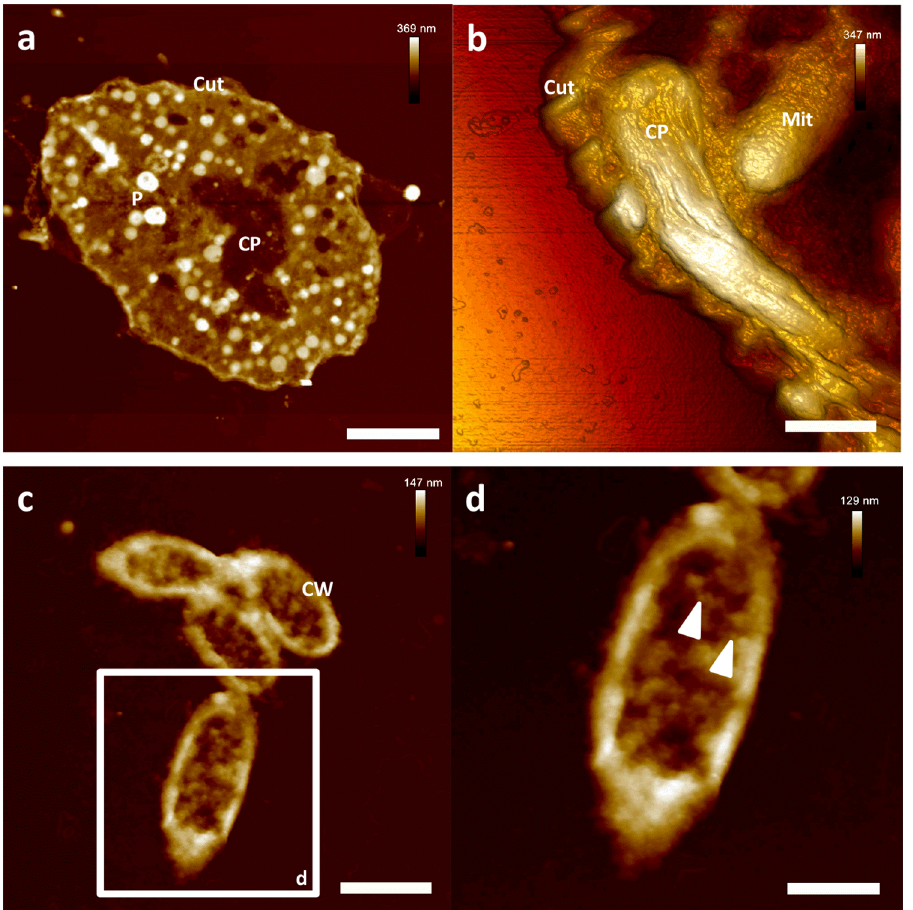
Figure 6. AFM-based ultrastructural imaging of eu- and prokaryotic cells of representative cell culture experiments. Nanoscopic resolution of the internal morphology of single cells. ( a ) Cross section of a single Euglena gracilis cell. ( b ) High resolution detail of an ultra-section from E. gracilis (3D representation). ( c ) Ultra- section of a group of E. coli bacteria. ( d ) Close up on a single E. coli individual. Note the depiction of single particles around 20 nm in diameter, most probably ribosomes (white triangles). Scale bars ( a ) 6 µm, ( b ) 940 nm, ( c ) 1 µm and ( d ) 520 nm. CP chloroplast, Cut cuticle, CW cell wall, Mit mitochondrium, P